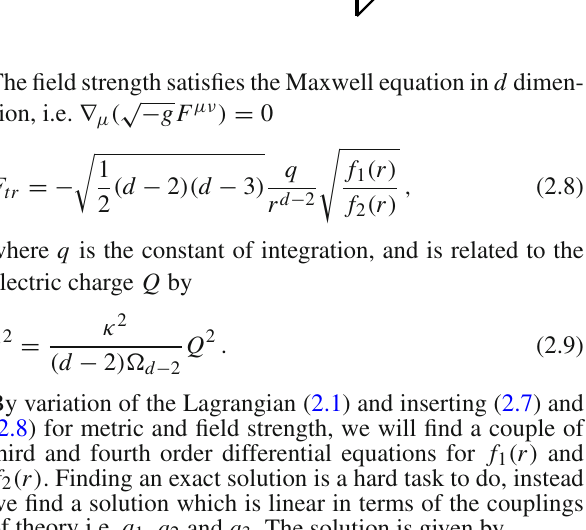
Fig. 1 Penrose diagram of charged (left) and neutral (right) black holes in GQC gravity. In the charged case we have depicted the outer horizon r + and the inner horizon r − , together with two singularities, one at the center of space-time r = 0, and one behind the inner horizon, at r = r s , denoted by the wiggly arcs in this picture. In the neutral case, however, the inner horizon disappears and space-like singularities appear, therefore the WDW patch should be ended on the